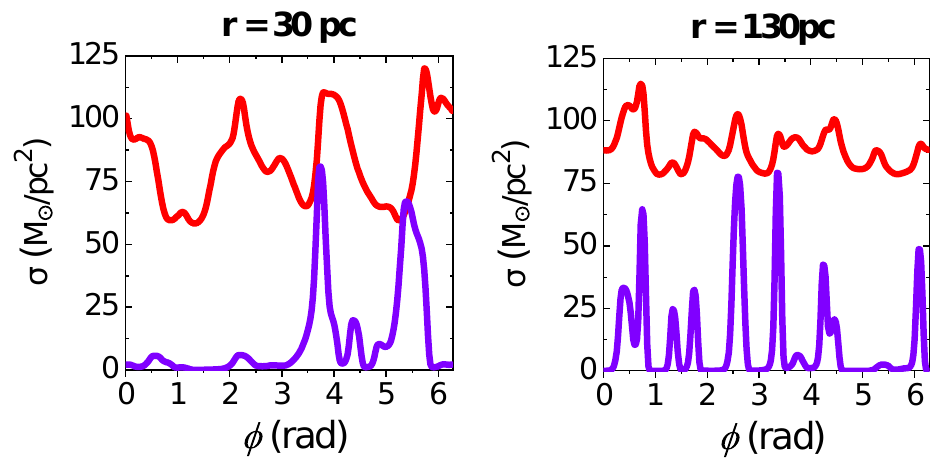
Figure 5. Azimuthal dust (purple color) and gas (red color) density variations (in [ M (cid:12) pc − 2 ]) for the reference model M233 at the two fixed radii: r = 30 pc (on the left ) and r = 130 pc (on the right ) at the time t = 1